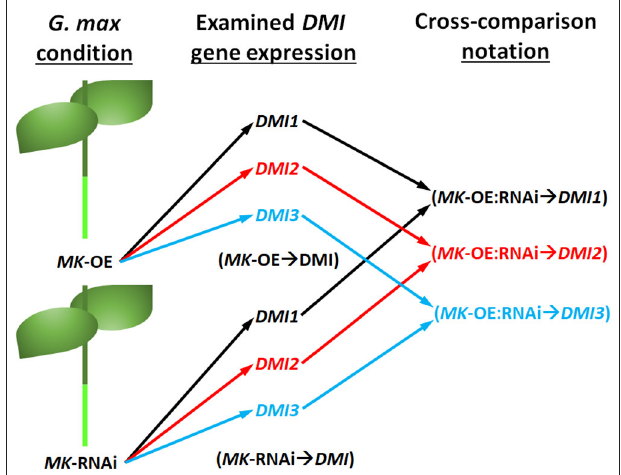
FIGURE 5 | Flow chart of the cross comparison analyses made that used data presented in Figures 3 , 4 . The condition represents the MAPK ( MK ) -OE or -RNAi sample under study. The examined DMI gene expression represents the various examined DMI1 , DMI2, or DMI3 paralogs. The black, red, and blue arrows and text were used to distinguish between the different DMI ( DMI1 , DMI2 , and DMI3 ) genes. The notation of the cross comparisons took into consideration that data from both the MK -OE and MK -RNAi analyses were used in examining the DMI gene expression (i.e., MK -OE:RNAi → DMI